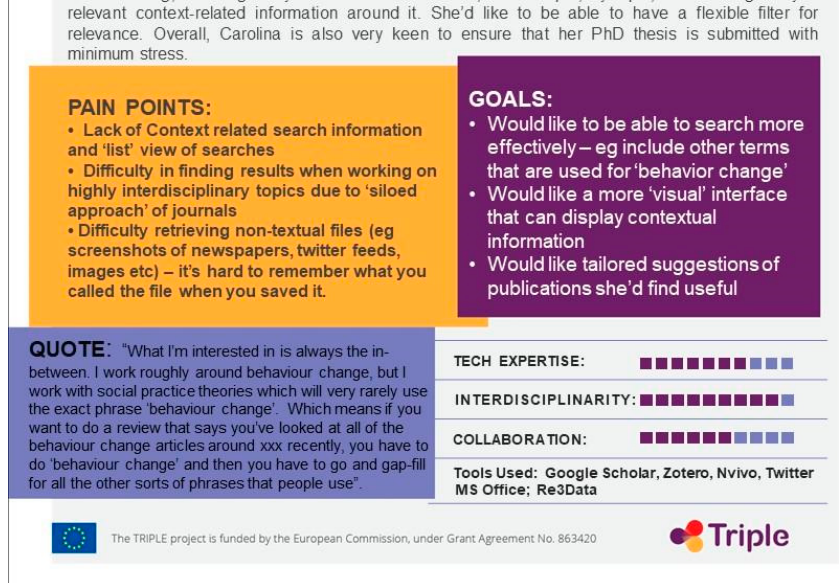
Figure 5. Example of an academic persona created from the results of the qualitative interviews and subsequent thematic analysis.